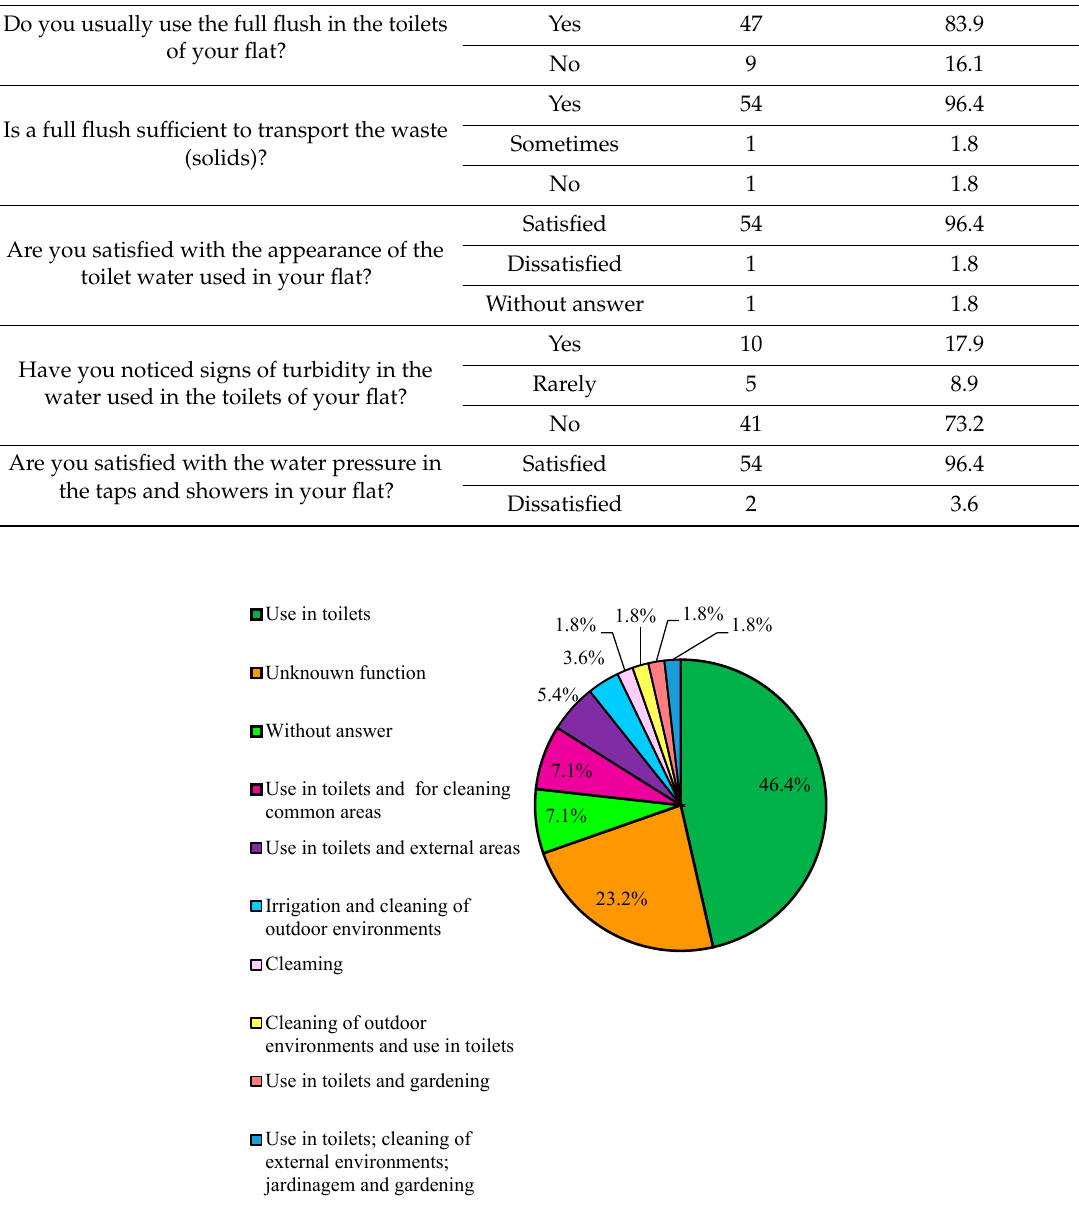
Table 9. Questions related to toilet usage habits, toilet flush performance, satisfaction with the appearance of water and the water pressure used in taps and showers.